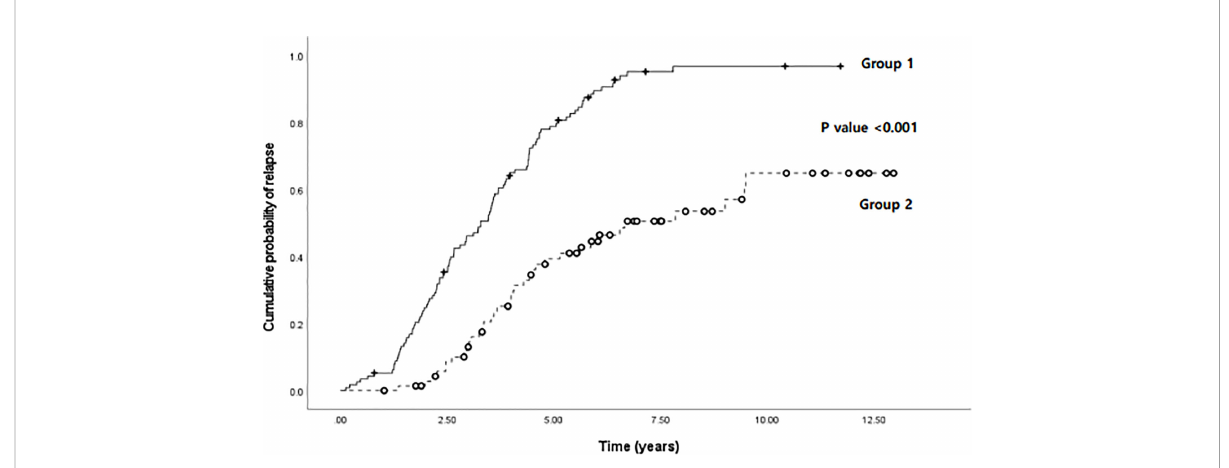
FIGURE 6 Comparison of cumulative probability of relapse according to time (years) between two groups: group 1, wherein the monocyte percentage was above the cutoff value (8.15%), and group 2, wherein the monocyte percentage was below the cutoff value, in pediatric patients with Crohn ’ s disease and ulcerative